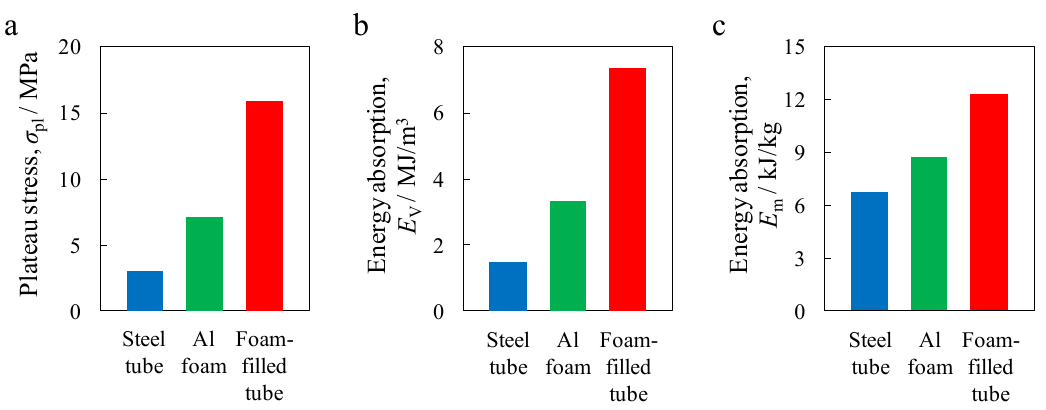
Figure 10. Comparison of mechanical properties between steel tube, Al foam and Al foam-filled steel tube: ( a ) Plateau stress; ( b ) Energy absorption per unit volume; and ( c ) Energy absorption per unit